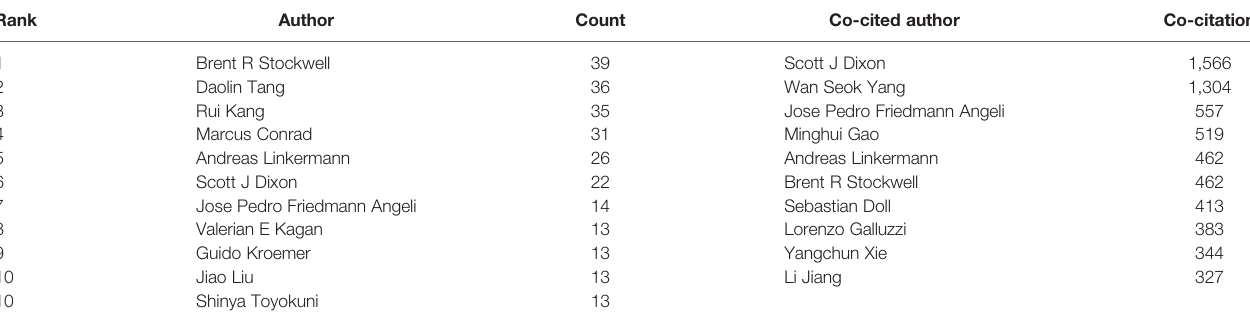
TABLE 4 | The top 10 authors and co-cited authors of ferroptosis research.